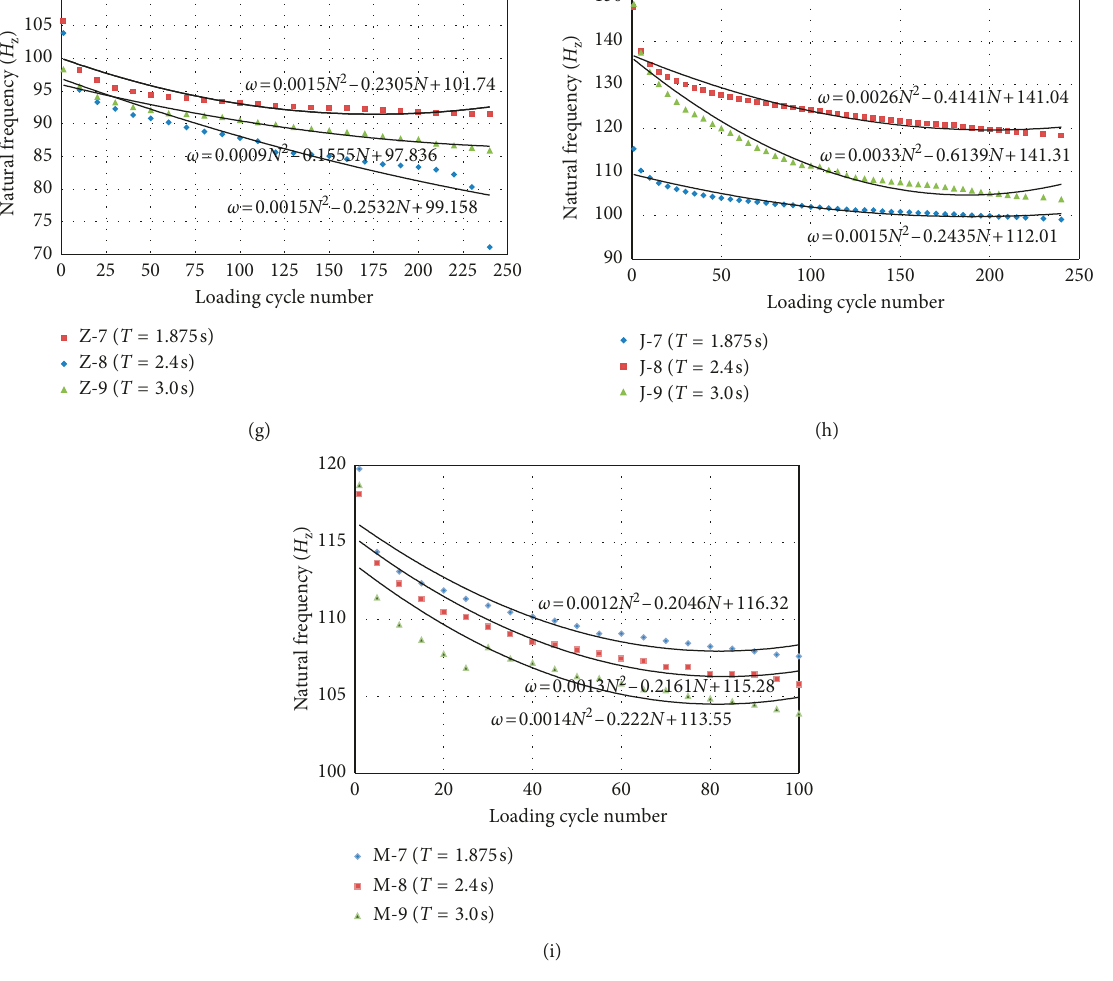
Figure 9: Natural frequency-change curves. (a) Z-1, Z-2, Z-3. (b) J-1, J-2, J-3. (c) M-1, M-2, M-3. (d) Z-4, Z-5, Z-6. (e) J-4, J-5, J-6. (f) M-4, M-5, M-6. (g) Z-7, Z-8, Z-9. (h) J-7, J-8, J-9. (i) M-7, M-8,